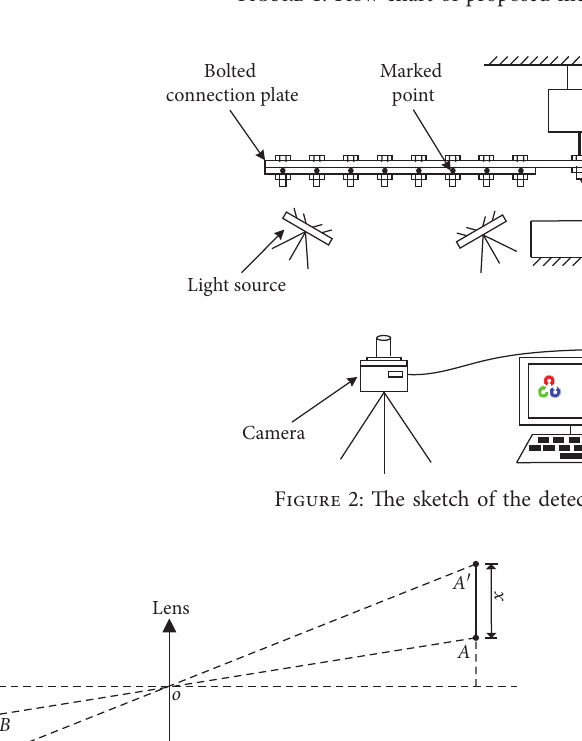
Figure 1: Flow chart of proposed method for bolt looseness detection.